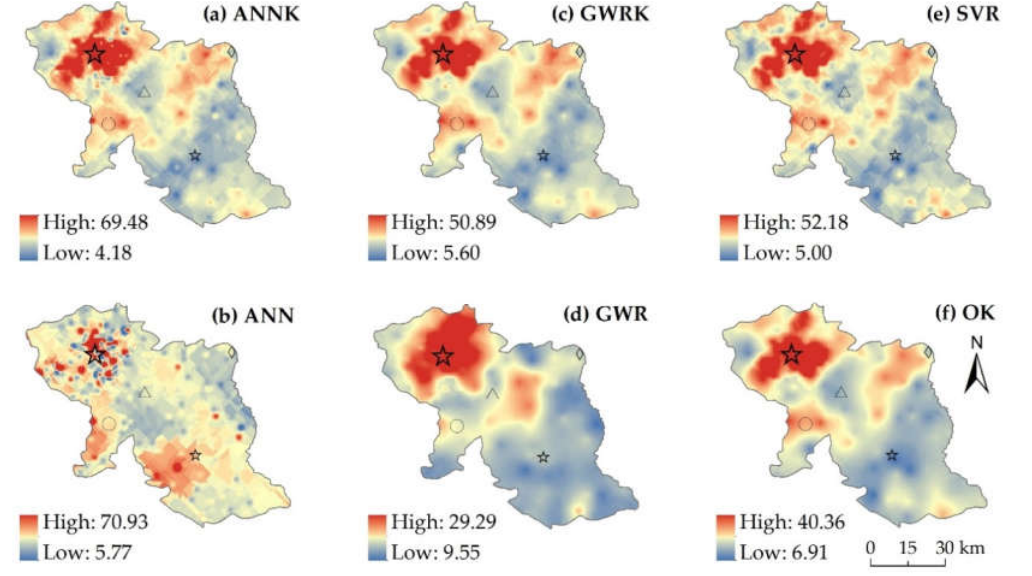
Figure 5. Maps of predicted SOC content (g · kg − 1 ) produced by ANNK ( a ), artificial neural networks (ANN) ( b ), GWRK ( c ), geographically weighted regression (GWR) ( d ), support vector machines for regression (SVR) ( e ) and ordinary kriging (OK) ( f ).